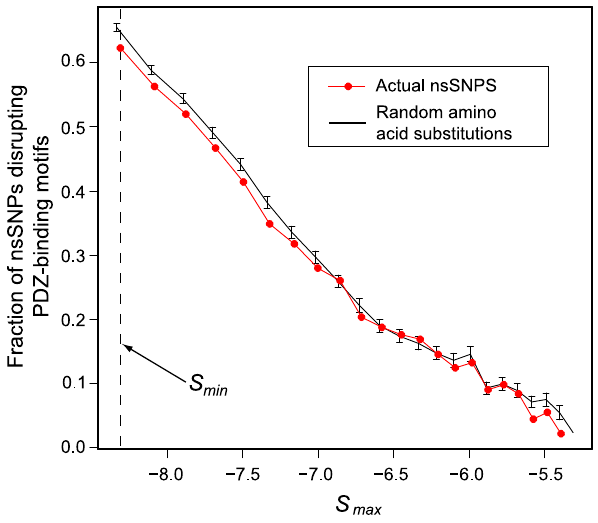
slightly under-represented in human proteins. The red curve shows the fraction of known nsSNPs predicted to disrupt PDZ-binding motifs for different values of the threshold S max . The black curve shows the same data for random amino acid substitutions on residues affected by nsSNPs in human C-termini (error bars show standard deviation for 1000 randomization of nsSNPs).